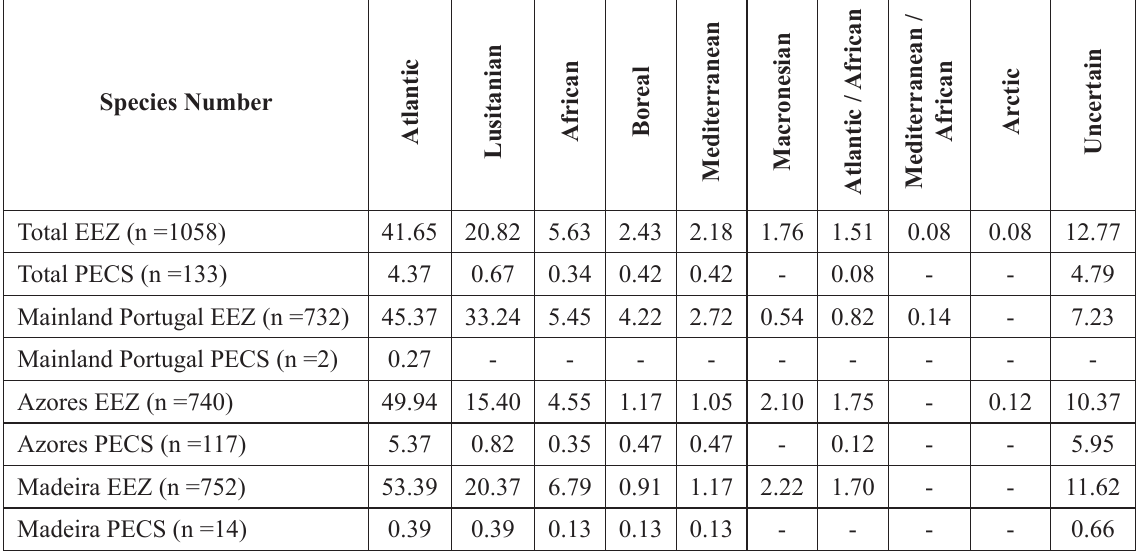
Table 4. Percentage of species by biogeographic group. Number of species is provided within parentheses for each area, including the EEZ and the area corresponding to the proposed extention of the continental shelf